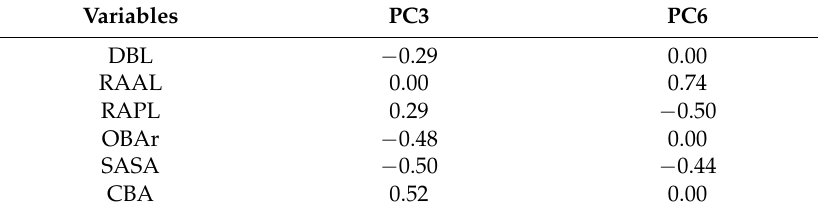
Table 9. Principal Components (PC3 and PC6) and the anatomical structures of females of N . elegantalis .